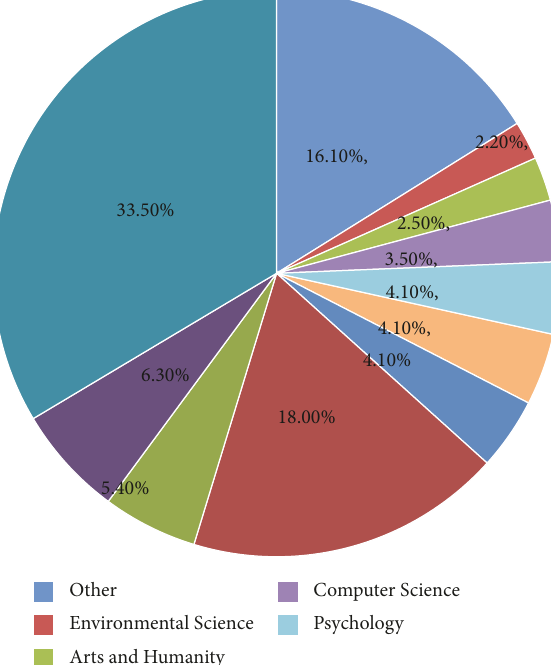
Figure 12: Pie chart depicting article distribution by disciplines for systematized review articles.